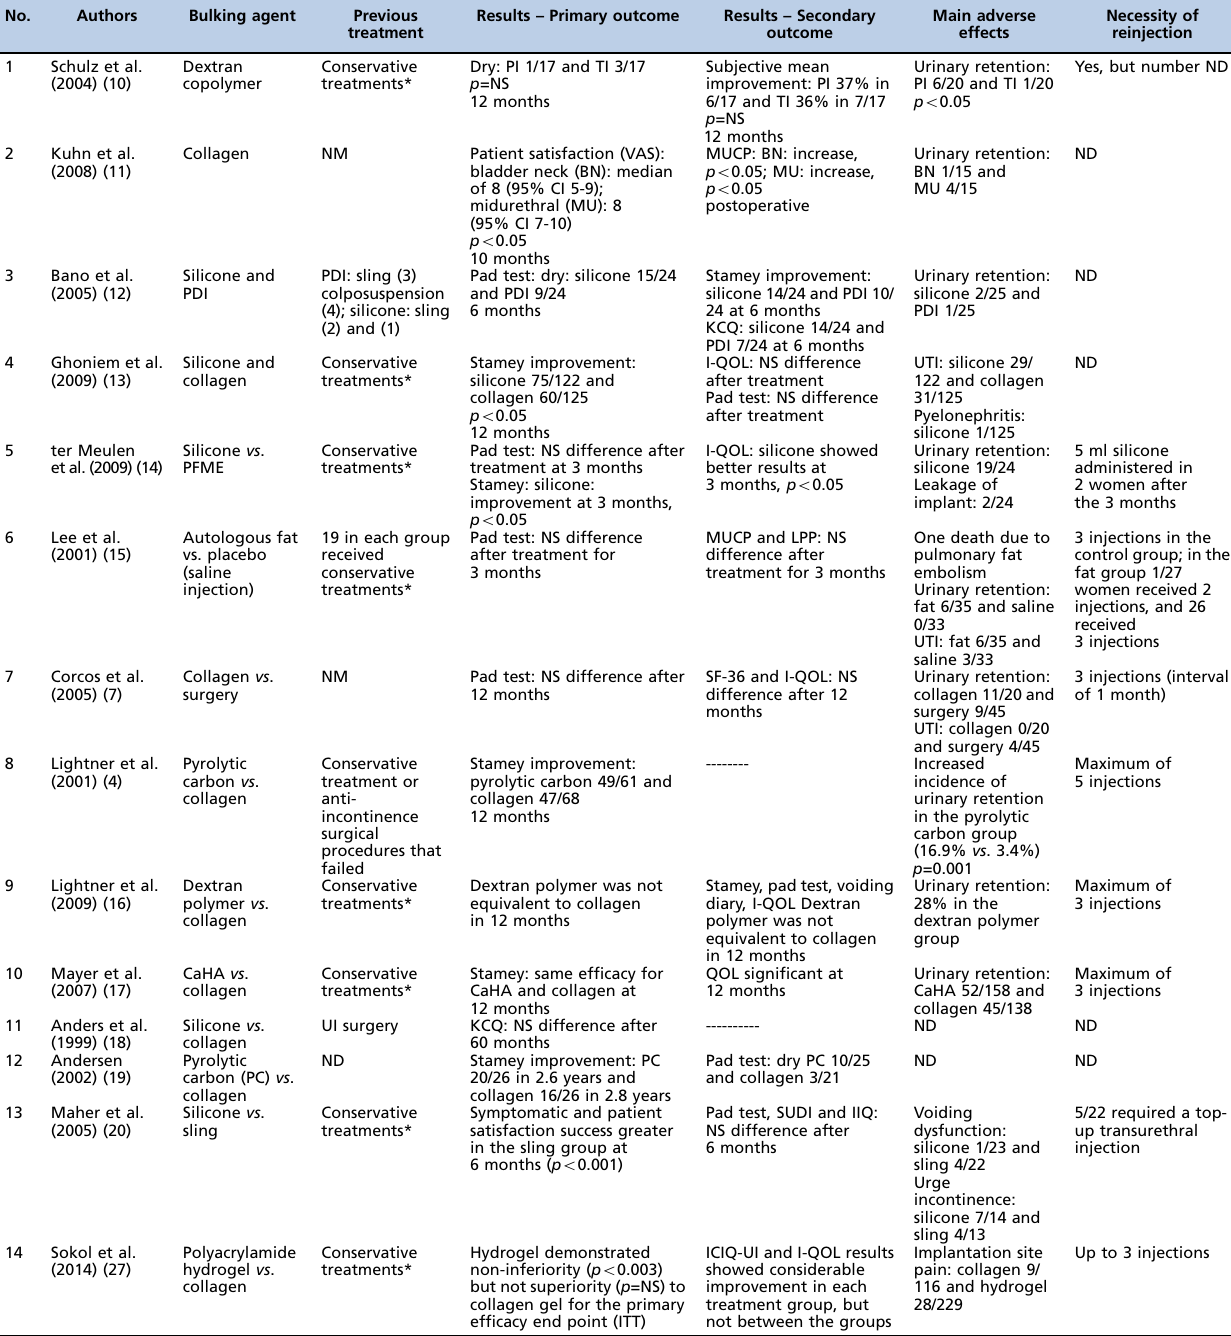
Table 2 - Main results of the selected studies and their main adverse effects.